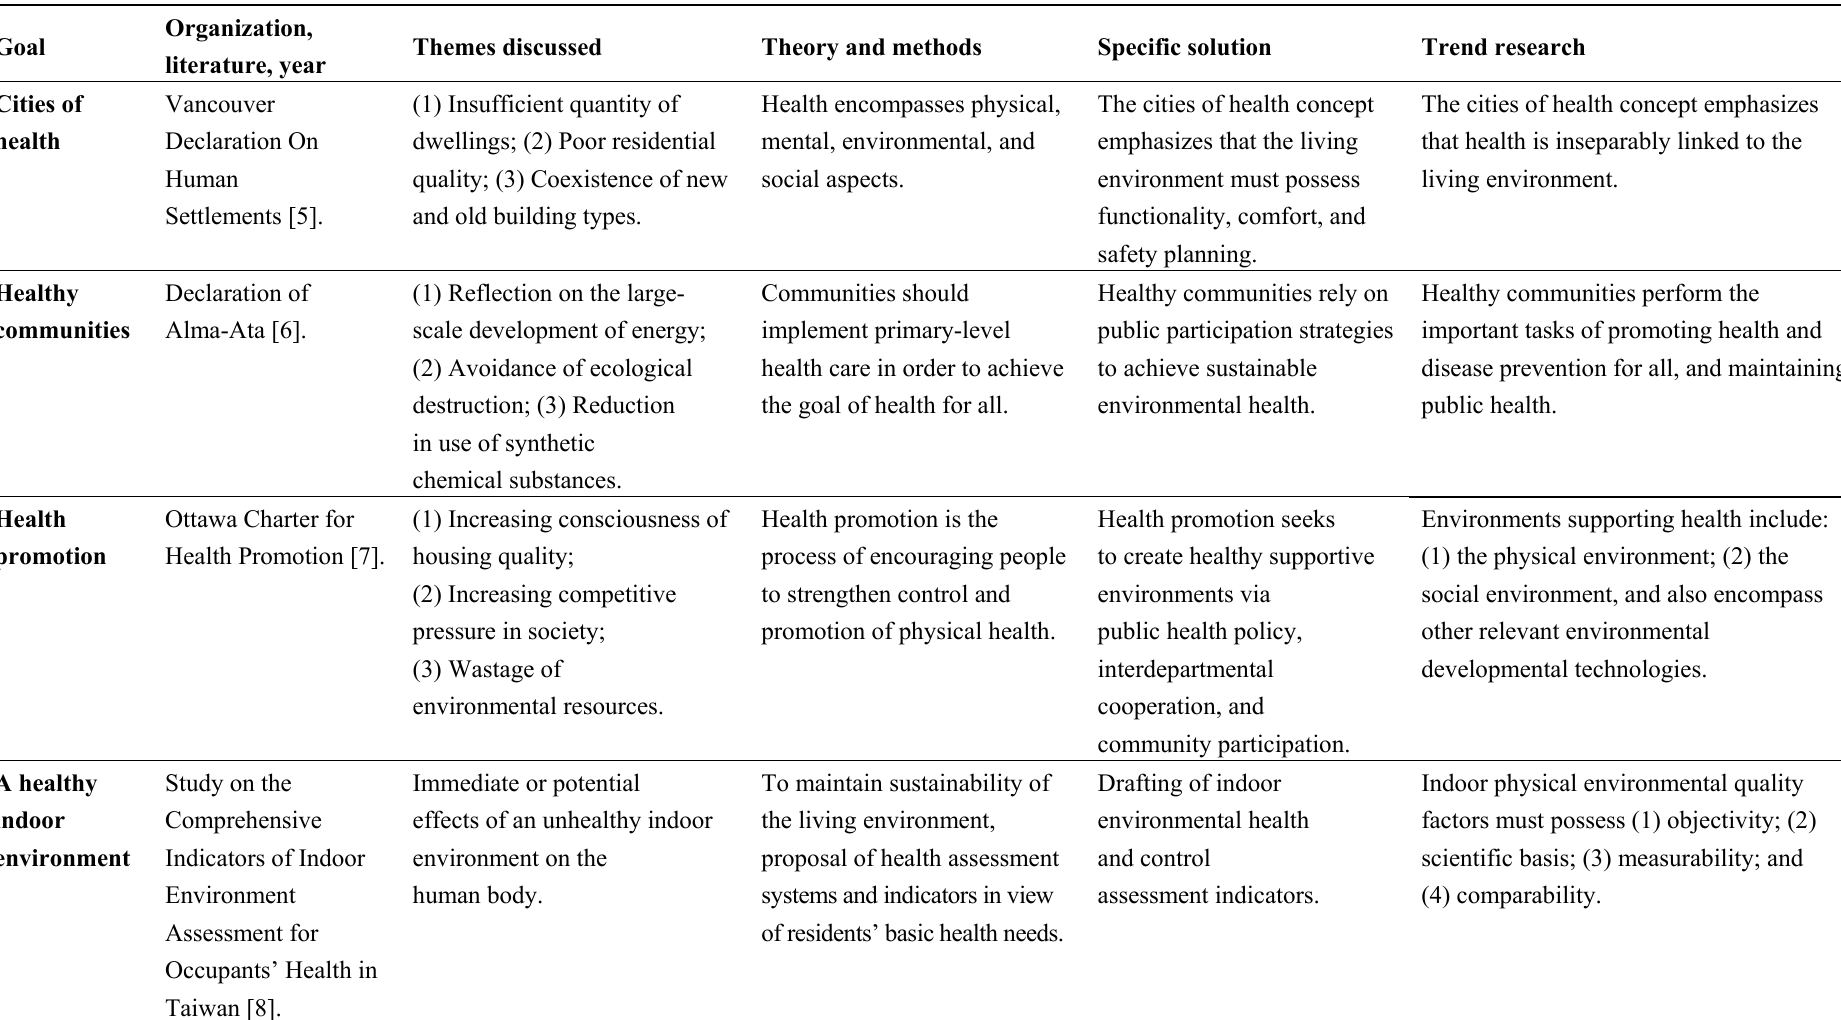
Table 1. Review of literature on environmental